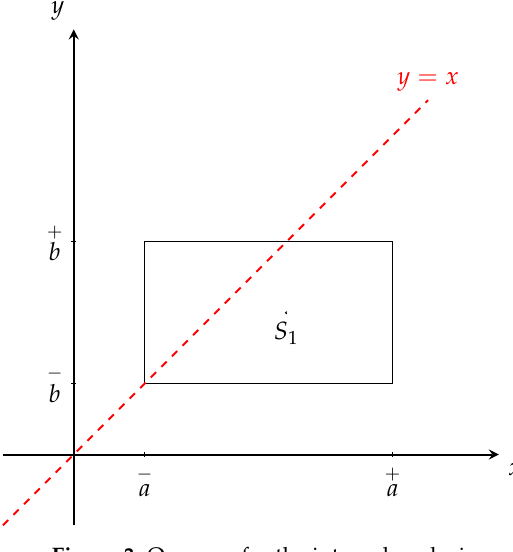
Figure 3. One case for the interval